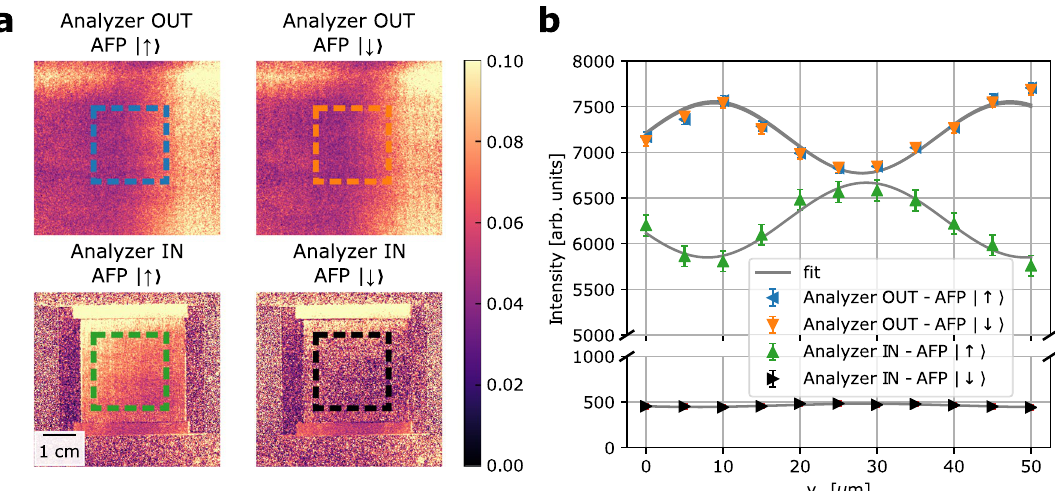
Figure 2. Modulation visibility for polarization-analyzed DFI. (a) Visibility maps for the symmetric Talbot-Lau polarized neutron grating interferometer setup in four configurations: without the polarization analyzer in place ↑ (cid:30) (top left), without the polarization analyzer in place and spin-down (cid:31) ↓ (cid:30) (top right), with the and spin-up (cid:31) (cid:31) (cid:31) ↑ (cid:30) (bottom left) and with the polarization analyzer in place and polarization analyzer in place and spin-up (cid:31) (cid:31) ↓ (cid:30) (bottom rigth). (b) Intensity modulation for the 4 different color coded configurations reported spin-down (cid:31) (cid:31) in (a) and the corresponding fitted sinusoidal curves. The color coded boxes in (a) delimit the fitted area for the intensity modulation